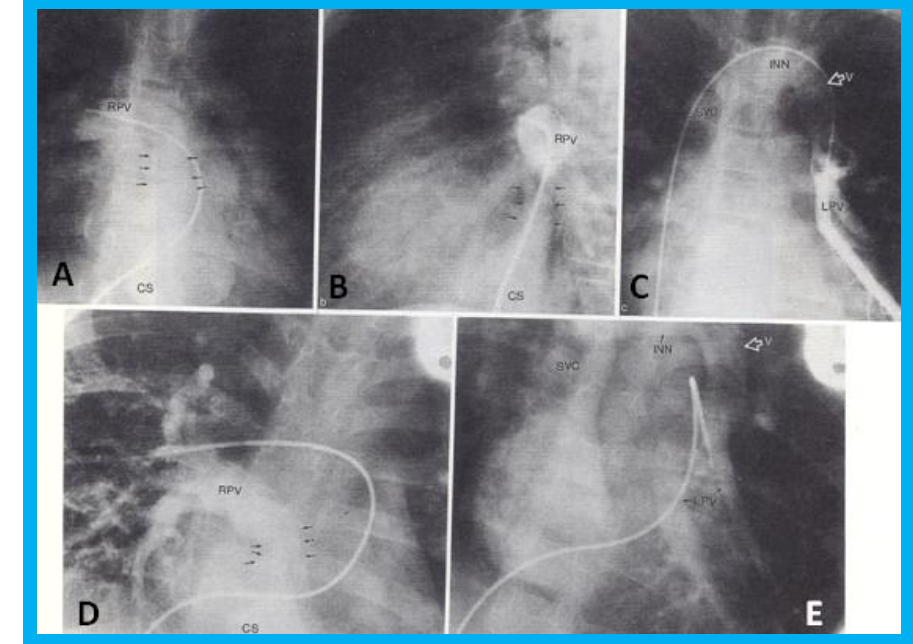
Figure 7. Selected cineangiographic frames from postero-anterior ( A , D , E ) and lateral ( B , C ) views of case 1 ( A – C ) and case 2 ( D , E ) demonstrating mixed total anomalous pulmonary venous connection. In A and B, levo-angiographic frames following right pulmonary artery cineangiogram demonstrated entry of right pulmonary vein (RPV) into the coronary sinus (CS) in case 1. In C is the selected angiographic frame from left pulmonary vein (LPV) cineangiogram demonstrating pulmonary venous drainage into the vertical vein (V) and then into the innominate vein (INN) and superior vena cava (SVC), also of case 1. In D, levo-angiographic frame following right pulmonary artery cineangiogram demonstrating entry of right pulmonary vein (RPV) into the coronary sinus (CS) in case 2 is shown. In E, levo-angiographic frame following left pulmonary artery cineangiogram demonstrating drainage of left pulmonary veins (LPV) into the vertical vein (V) and then into the INN and SVC of case 2 is shown. In A, B, and D, the connections of the RPVs to the CS are marked with arrows to improve clarity. Reproduced from Reddy S.C.B., et al. [9].